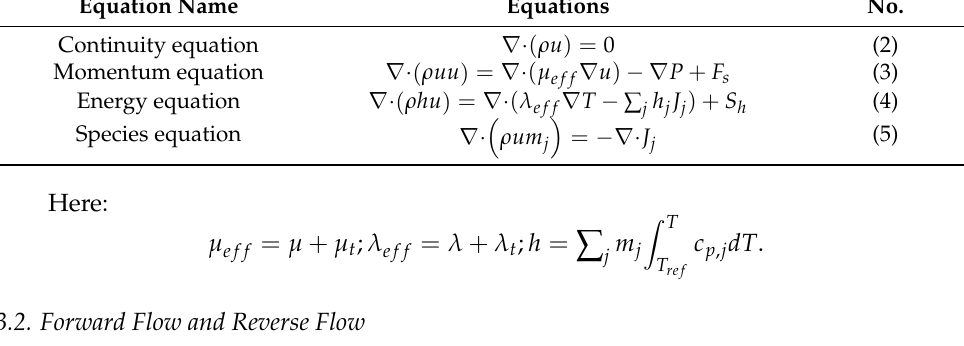
Figure 4. Relationship between Gibbs free energy and temperature.